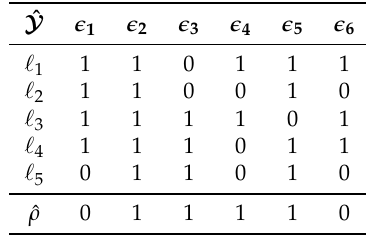
Table 2. ( 0.6,0.3, ( 0.5,0.3 )) -level soft set of ˆ Γ